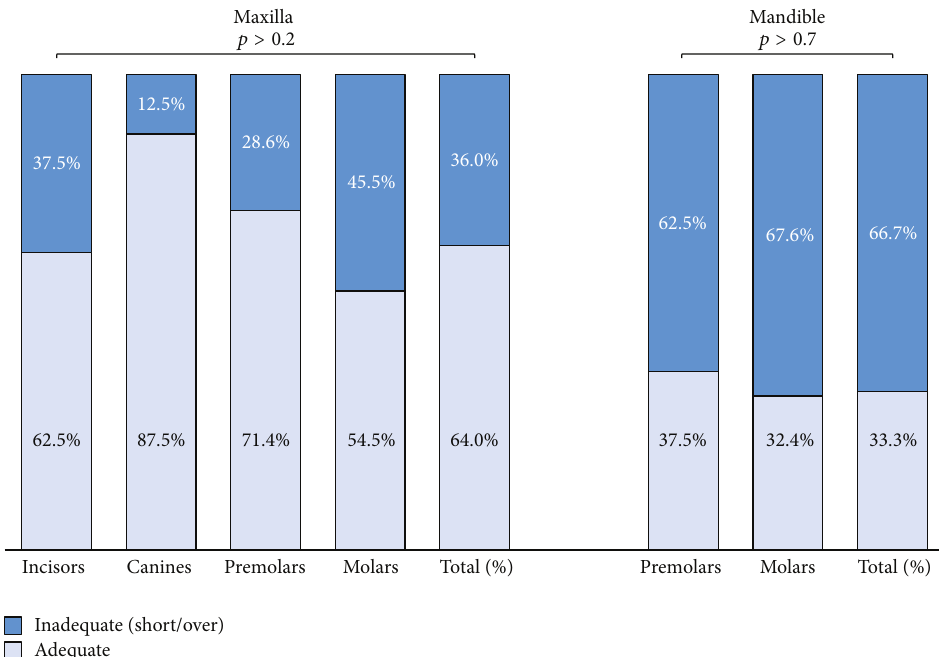
Figure 2: Length quality (%) in maxillary and mandibular root canal-filled teeth.